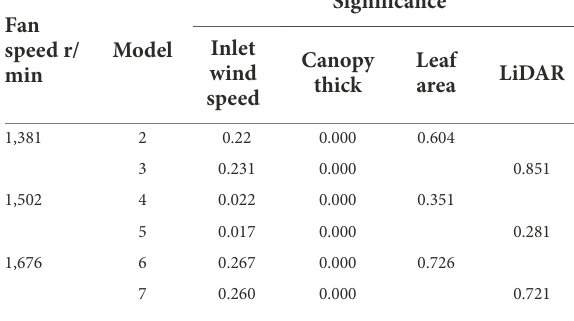
TABLE 4 Significance of the factors of the regression models of the canopy wind loss model under different spray fan speeds.